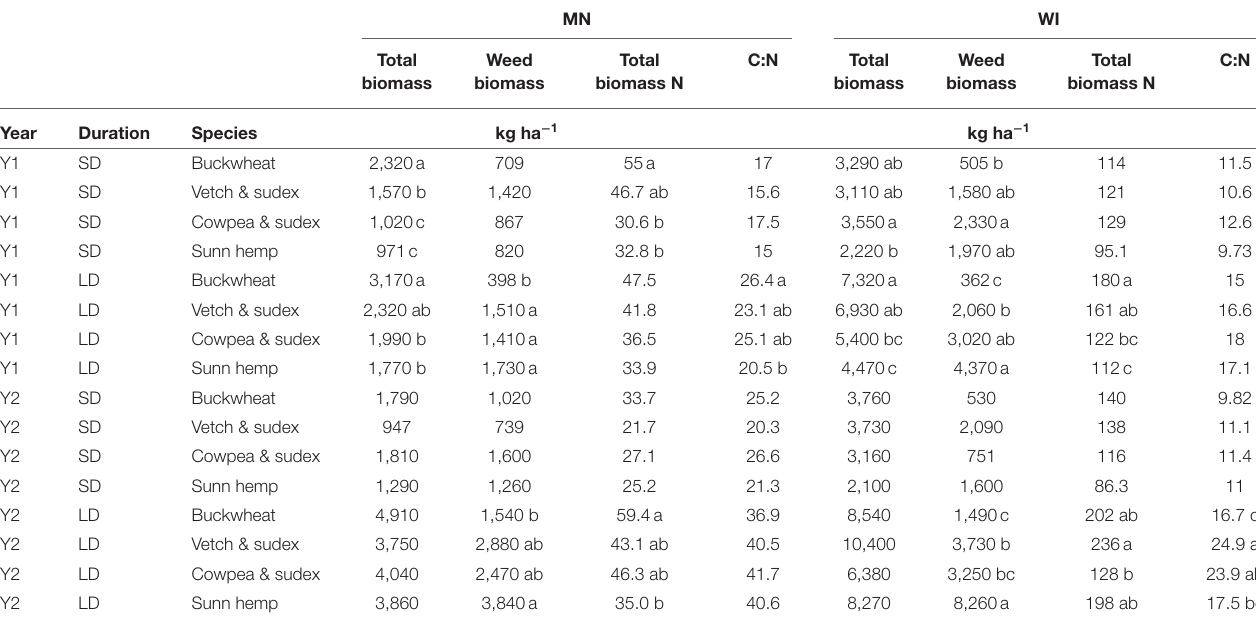
TABLE 3 | Total cover + weed biomass, weed biomass, total biomass N, and total biomass C:N for all four sites years, separated by duration and species